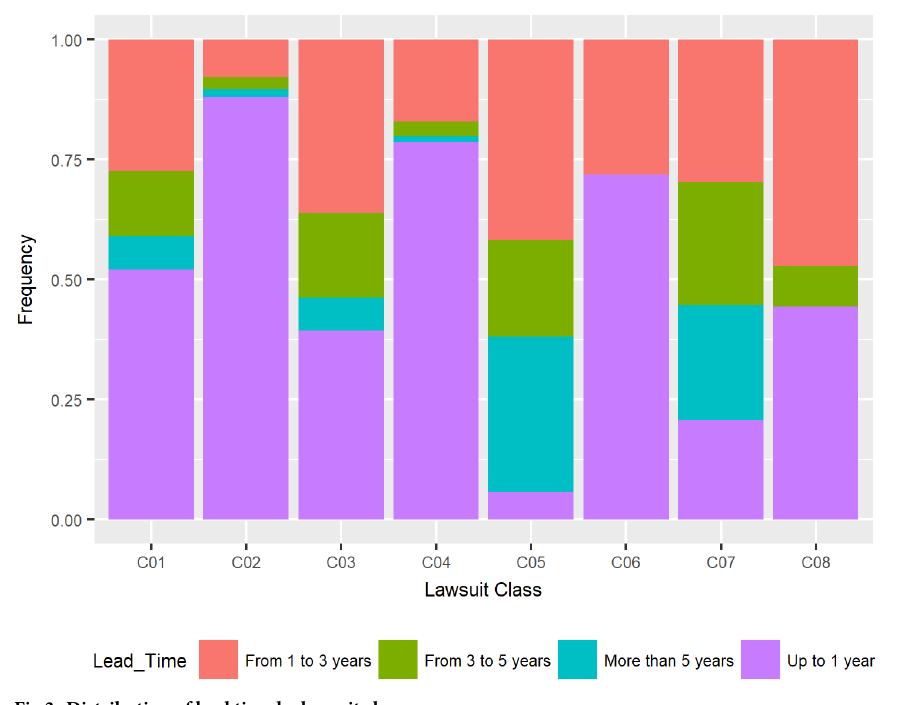
Fig 3. Distribution of lead time by lawsuit class.